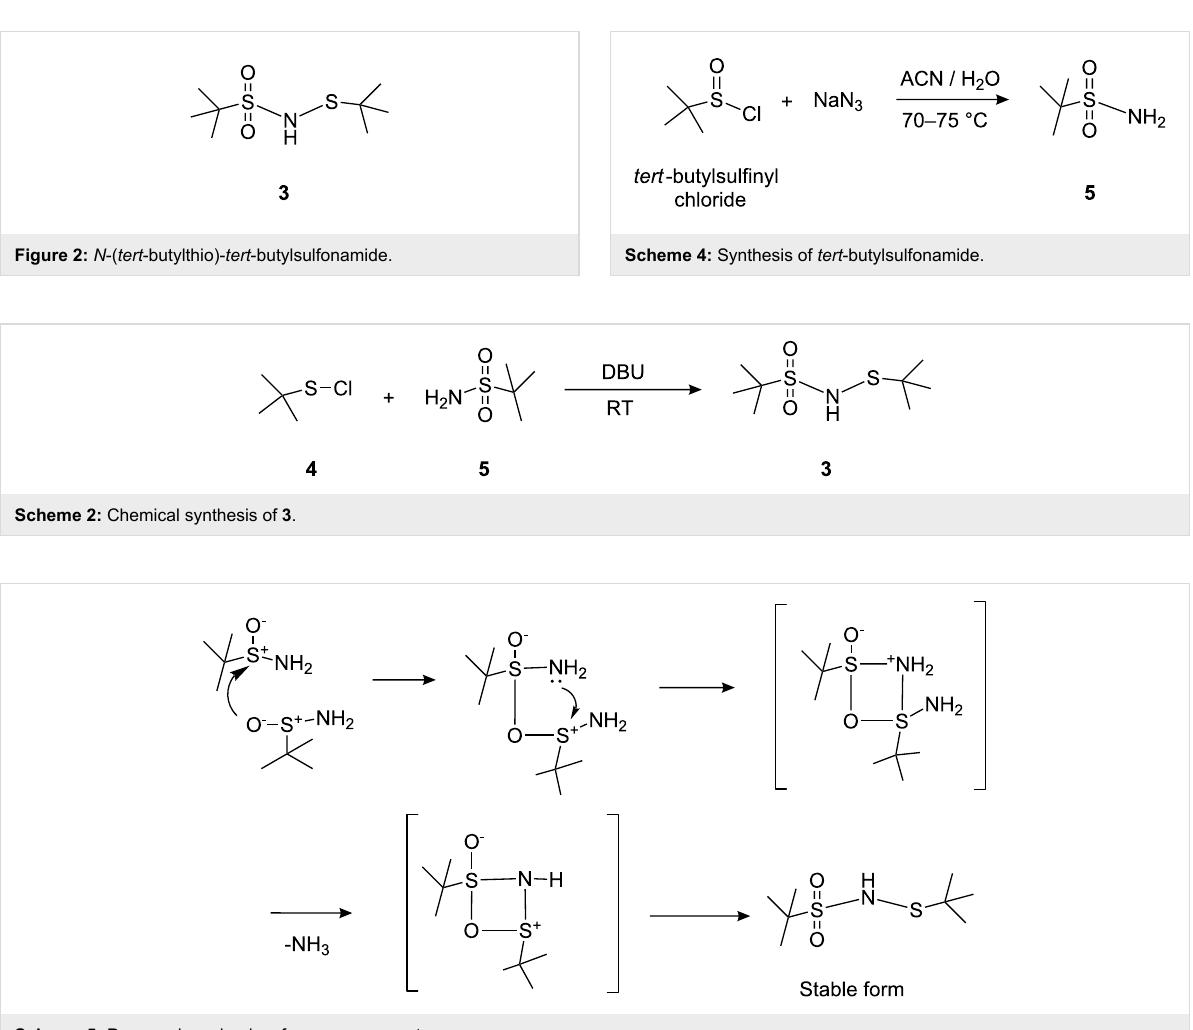
Scheme 5: Proposed mechanism for rearrangement.